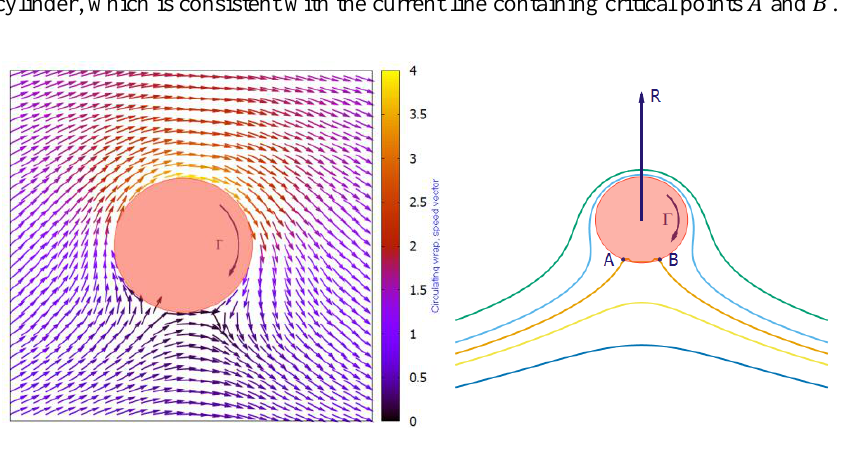
Fig. 5. The velocity field of a plane flow of an ideal fluid (left) and a streamline (right) in the case of a circulation flow around a circular cylinder